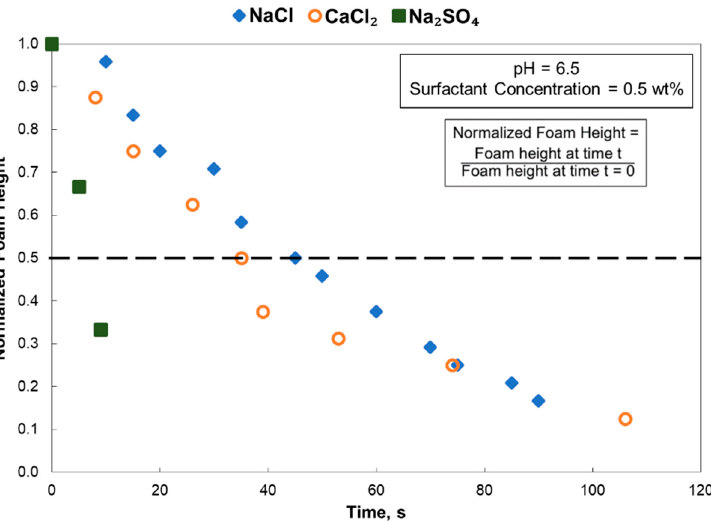
Figure 12. Role of multivalent cations and sulfate anions on the foam stability at 150 °F (65 °C) and 500 psi (34.5 bar).